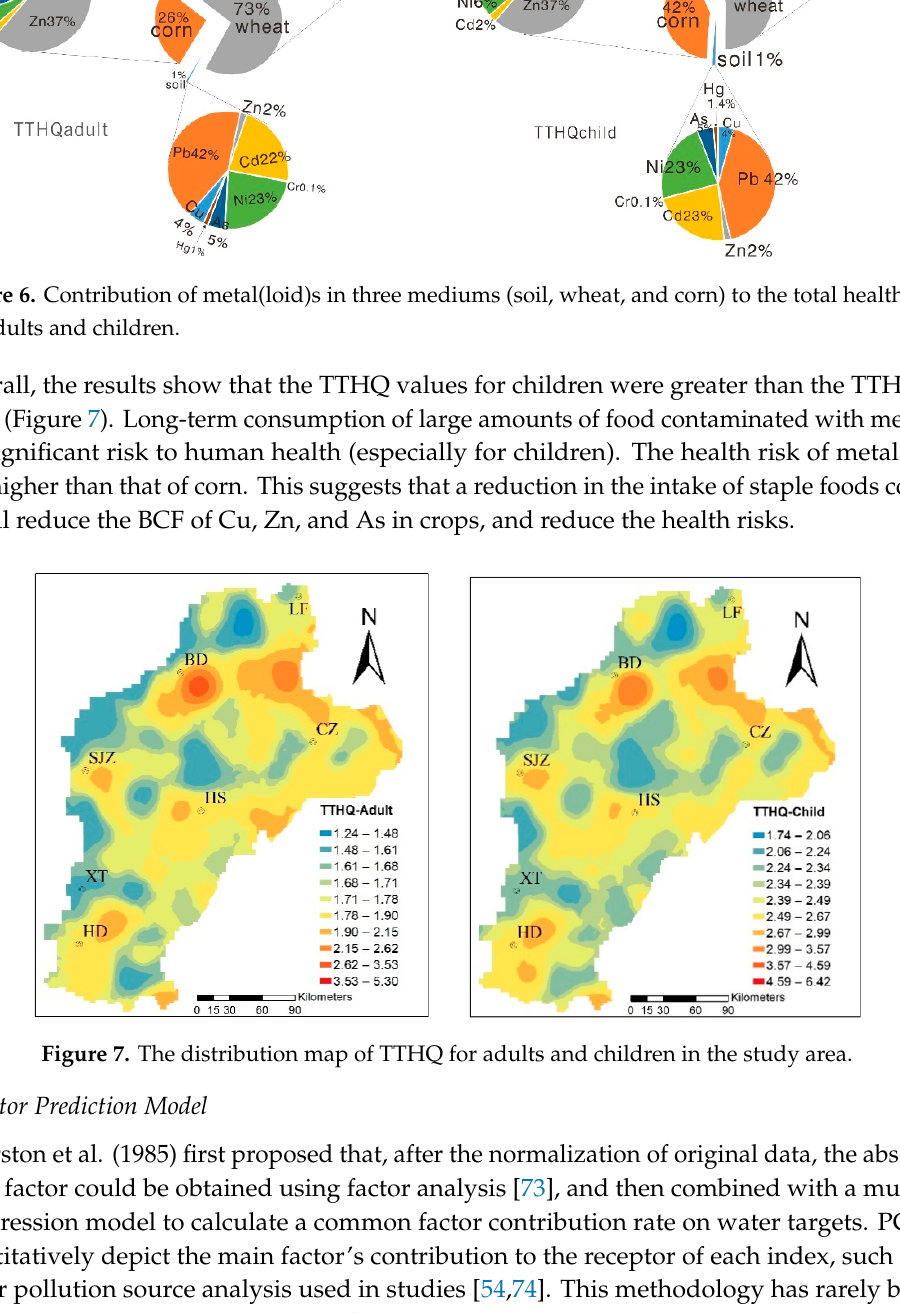
Figure 7. The distribution map of TTHQ for adults and children in the study area.